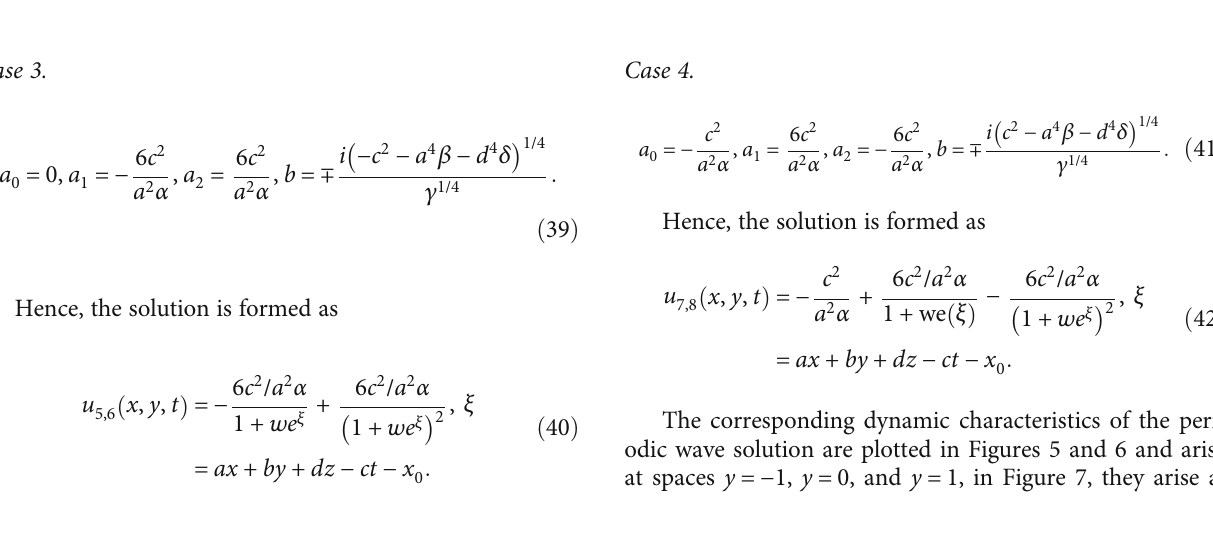
Figure 6: Graph of Eq. (38) for the ( 2 + 1 )-dimensional Benjamin-Ono equation at a = 2, α = 2, β = − 3, c = 2, γ = 2, r = 1, w = 0 : 3, d = 2, δ = − 2, z = 1, t = 20 and for 2 plot spaces y = − 1, 0, 1